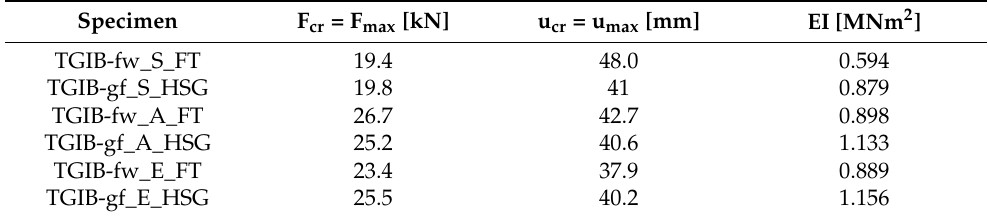
Table 12. Comparison of results of measurements for TGIB-fw with fully tempered glass (FT) and